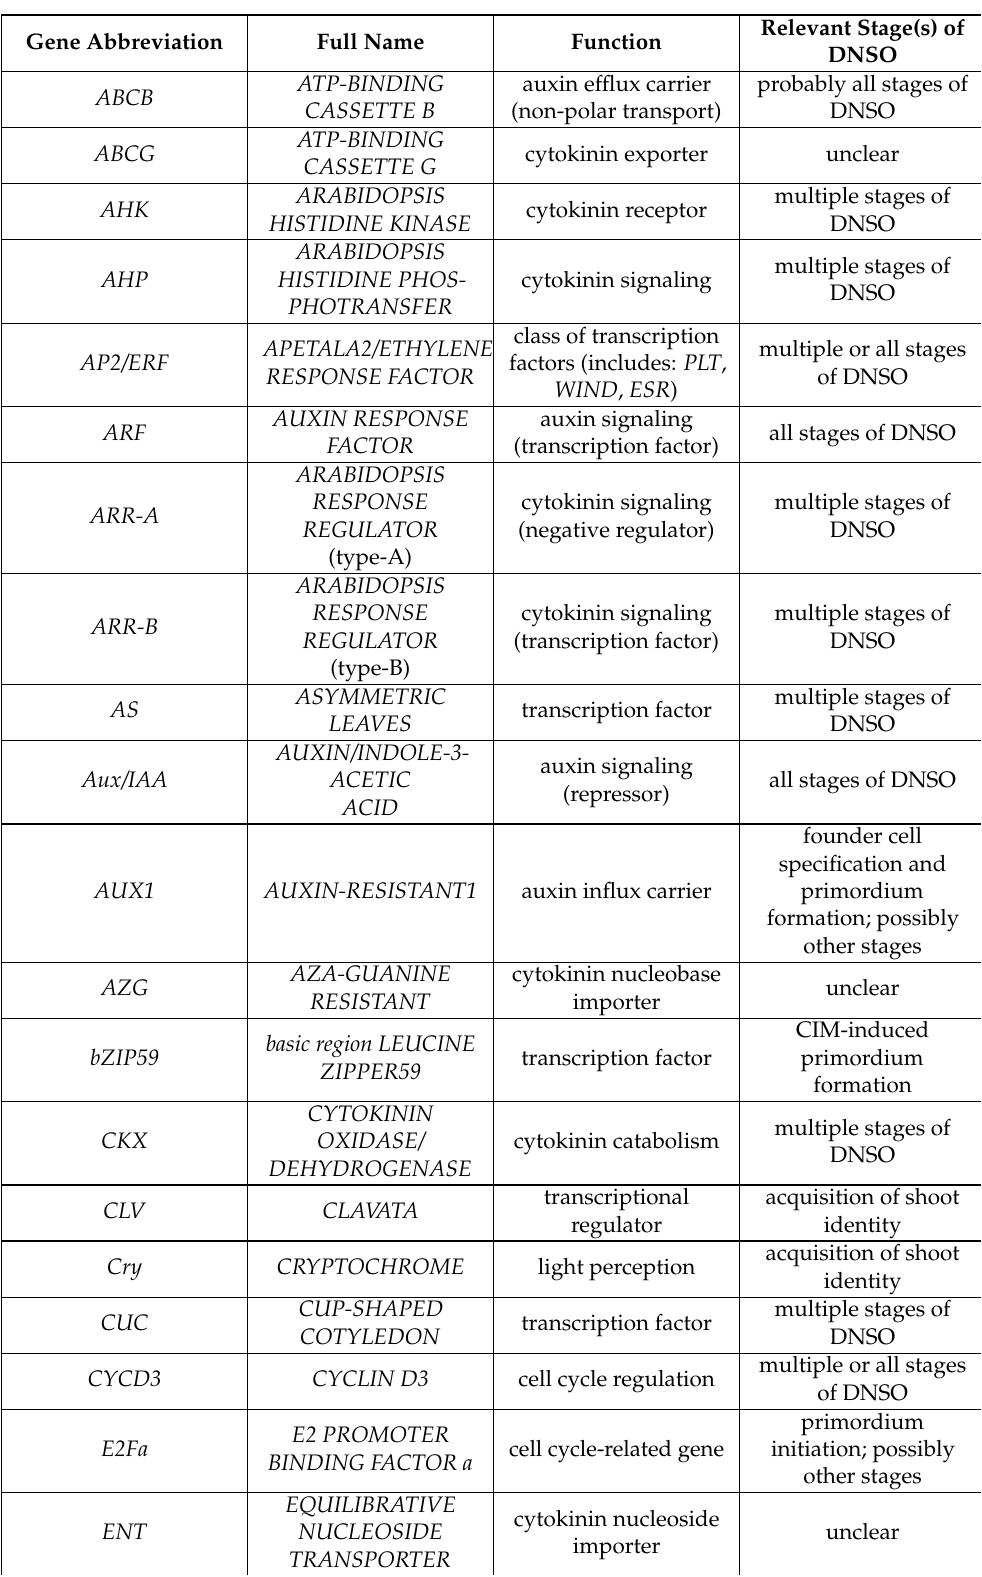
Table 1. A summary of genes involved in auxin and cytokinin transport and in de novo shoot organogenesis (DNSO). A brief explanation for the function of particular genes and their involvement in the stages of DNSO is